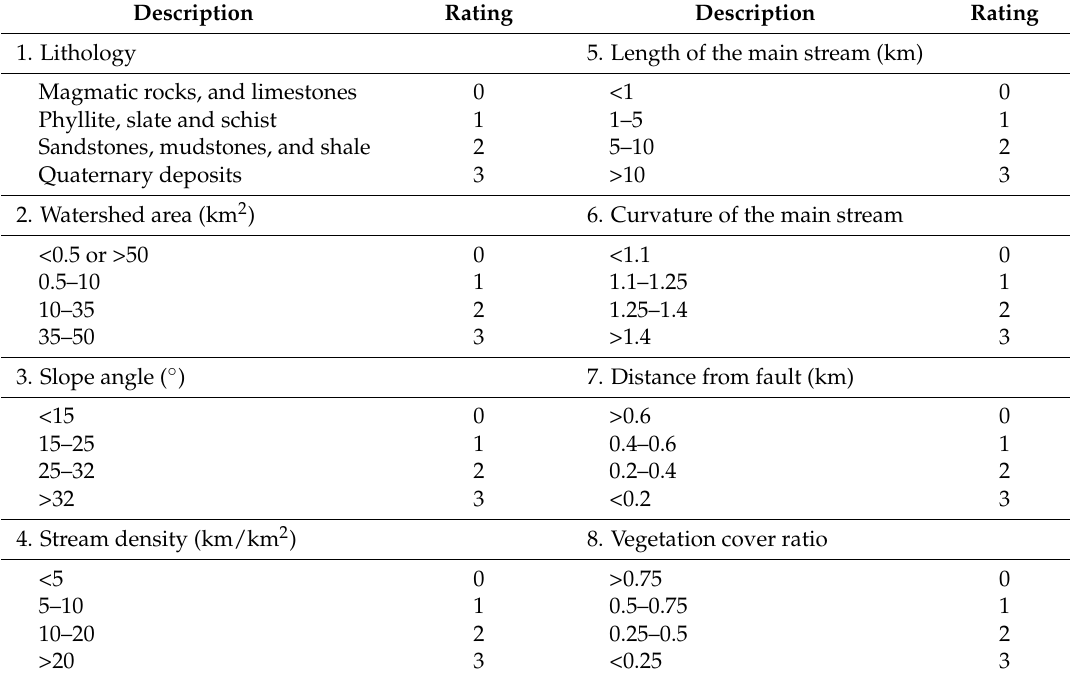
Table 1. Classification of influencing factors and their rating